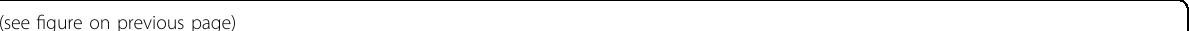
Fig. 2 Molecular signatures of the malignant cells and association with pathological characteristics in SBA. a UMAP plot exhibiting the cell identi fi cation by CNV values in the STRT and 10× datasets. b , c Boxplots in the upper panel showing average normalized expression of the malignant cells and normal epithelial cells. Dot plots in the lower panel showing the log 2 fold change (FC) of malignant cell relative to normal epithelial cell of each patient or dataset. d Representative IHC staining of MUC1 in adjacent normal and primary tumor tissues (original magni fi cation 100×). The rows of the paired normal and tumor samples are from the same patients, and three individual patients are listed. Scale bar, 100 μ m. e Dot plot showing the log odd ratio values of tumor/normal of corresponding TFs, with P values calculated by χ 2 test. f Violin plot showing the expression scores of absorptive and transport gene sets in malignant and normal epithelial cells from different intestinal regions. g Heatmap showing the expression scores of metabolism pathways in malignant and normal epithelial cells from different intestinal